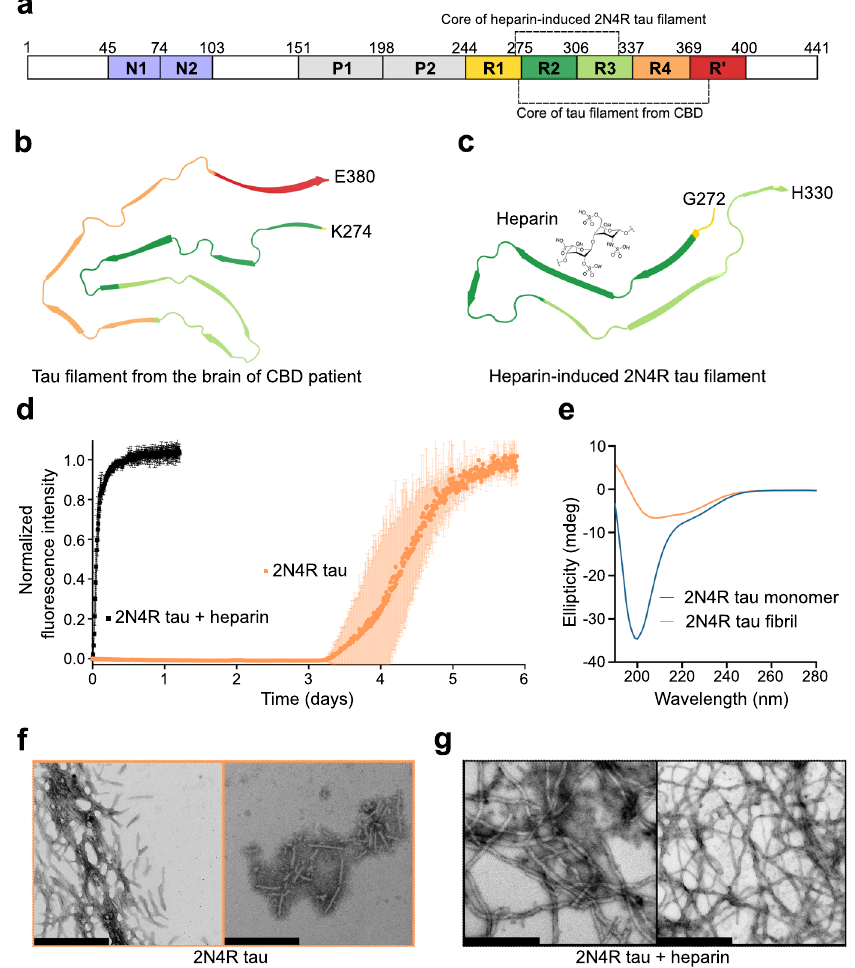
Fig. 1 Amyloid fi brils of tau without co-factors. a Schematic representation of the domain organization of 2N4R tau. N1 and N2 are two inserts subject to alternative splicing, P1 and P2 mark the proline-rich regions, and R1-R ’ are pseudo-repeats that bind to microtubules. Tau fi bril cores from CBD-brain and heparin-induced 2N4R fi brils are marked by dashed lines (see also ( b , c )). b CryoEM structure of tau fi lament (type 1) extracted from the brain of a patient with CBD (PDB code: 6TJO). c CryoEM structure of heparin-induced 2N4R tau fi brils (snake form; PDB code: 6QJH). A molecule of heparin is displayed to illustrate that these fi brils are formed in the presence of heparin. d Aggregation kinetics of 25 µ M 2N4R tau with (black) and without (orange) heparin. Data are presented as mean ± standard deviation of n = 3 independent samples. e Circular dichroism spectra of 2N4R tau monomer and heparin-free fi brils. f , g Negative-stain electron micrographs of 2N4R fi brils aggregated without heparin ( f ) or with heparin ( g ). Scale bar, 500 nm. Similar micrographs have been observed for both 2N4R fi brils aggregated in presence/absence of heparin with ten independently aggregated